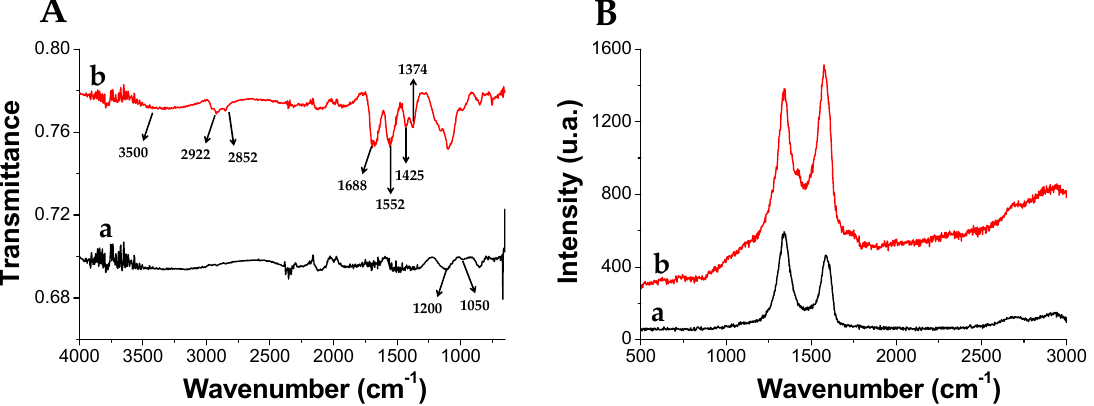
Figure 4. ( A ) FT-IR and ( B ) Raman spectra of ( a ) pristine rGO and ( b ) functionalized with TPSA (TPSA-rGO).